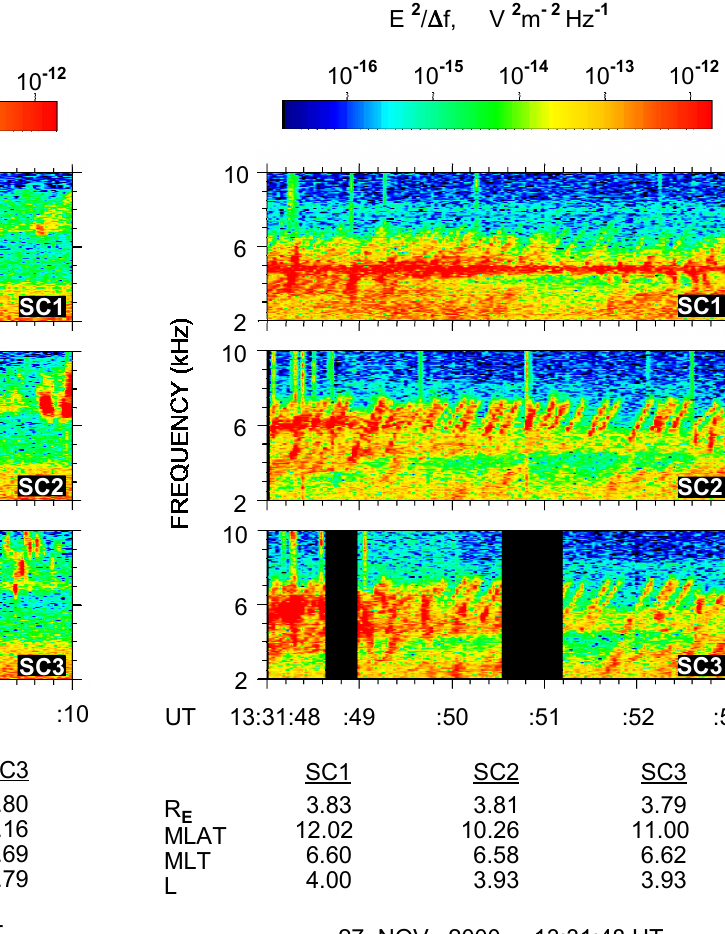
Fig. 7. Expanded time scale spectrogram of the chorus emissions in Fig. 4 starting at 13:31:48UT, well north of the magnetic equator. The spacecraft coordinates are given at the bottom of the plot for 13:31:48UT. Again, note the change in the frequency-time struc- ture compared to Fig. 6, and the good correlation between the three spacecraft from about 13:31:50 to